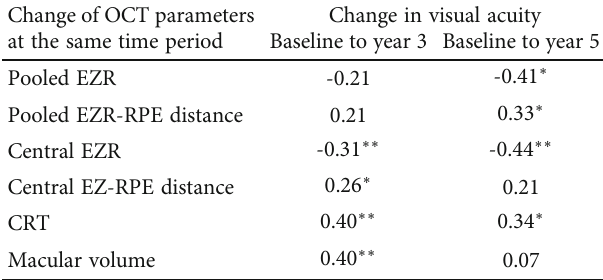
Table 3: Correlation analysis of changes in visual acuity and OCT parameters between baseline to third year and baseline to fi fth year. Spearman ’ s correlation coe ffi cient ρ between change of